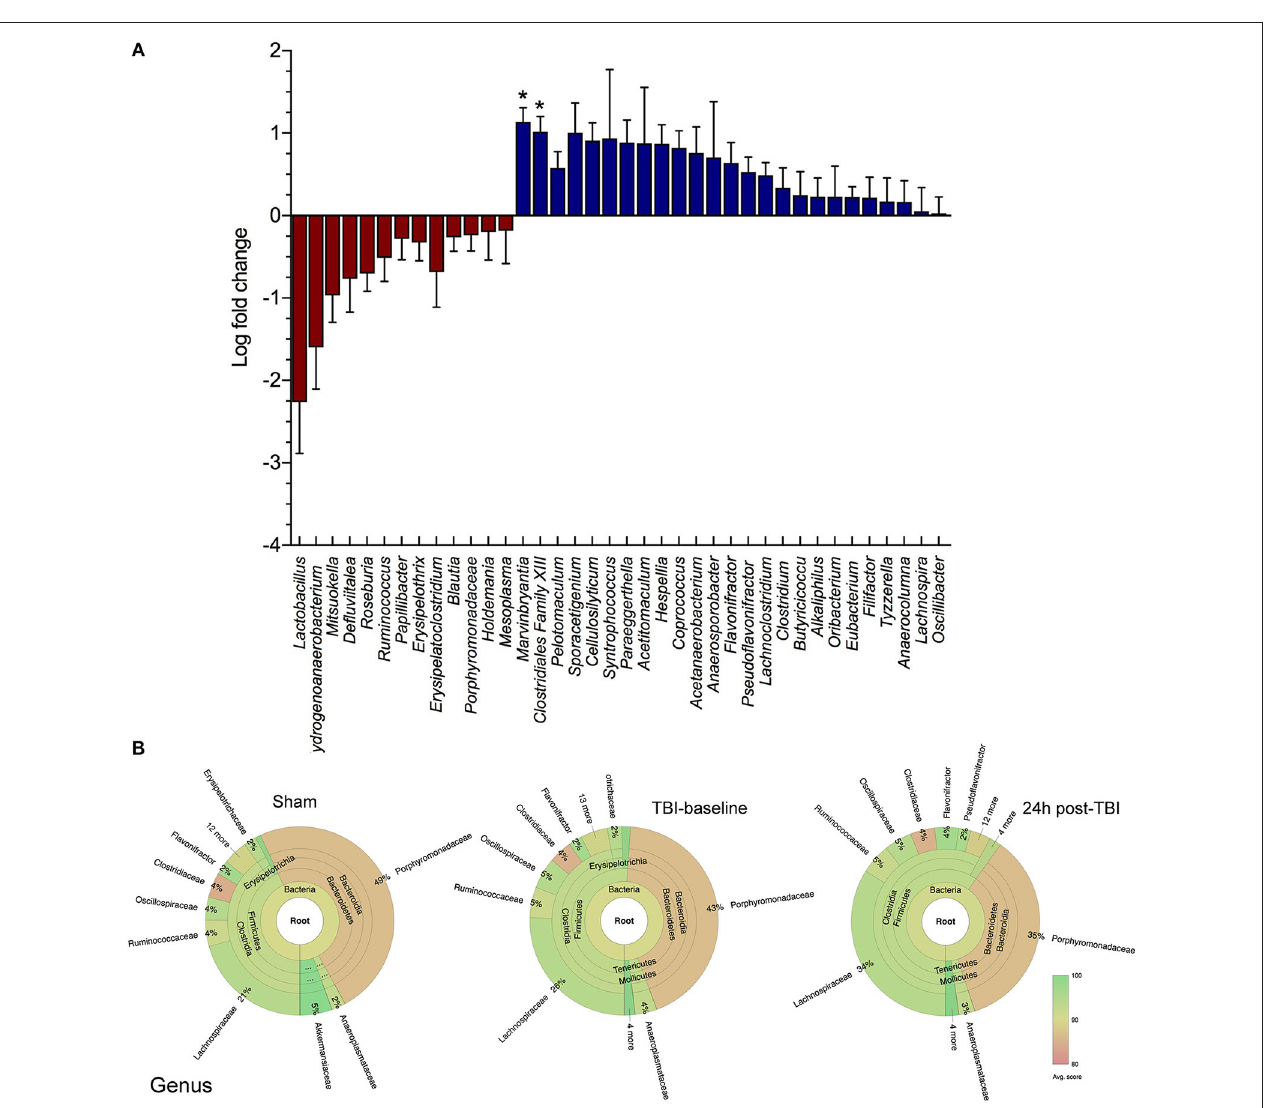
FIGURE 1 | Family and Genus level changes before and after brain injury. (A) Box and whiskers plot shows the microbial community analysis using short-read (Illumina) sequencing comparing TBI and Sham animals at baseline levels and 24h after brain injury ( n = 8/group). The genus Lactobacillus relative abundance is noticeably decreased, by up to > 2 log fold change ( p > 0.05). The Marvinbryantia ( p = 0.02) and Clostridiales genera (* p < 0.05) both significantly increase after TBI. (B) Krona chart highlights the genus differential abundance in Sham mice, TBI-baseline and 24h post-TBI mice. TBI-baseline and Sham exhibit similar compositions, while 24h post-TBI Krona plot highlights a shift in the community